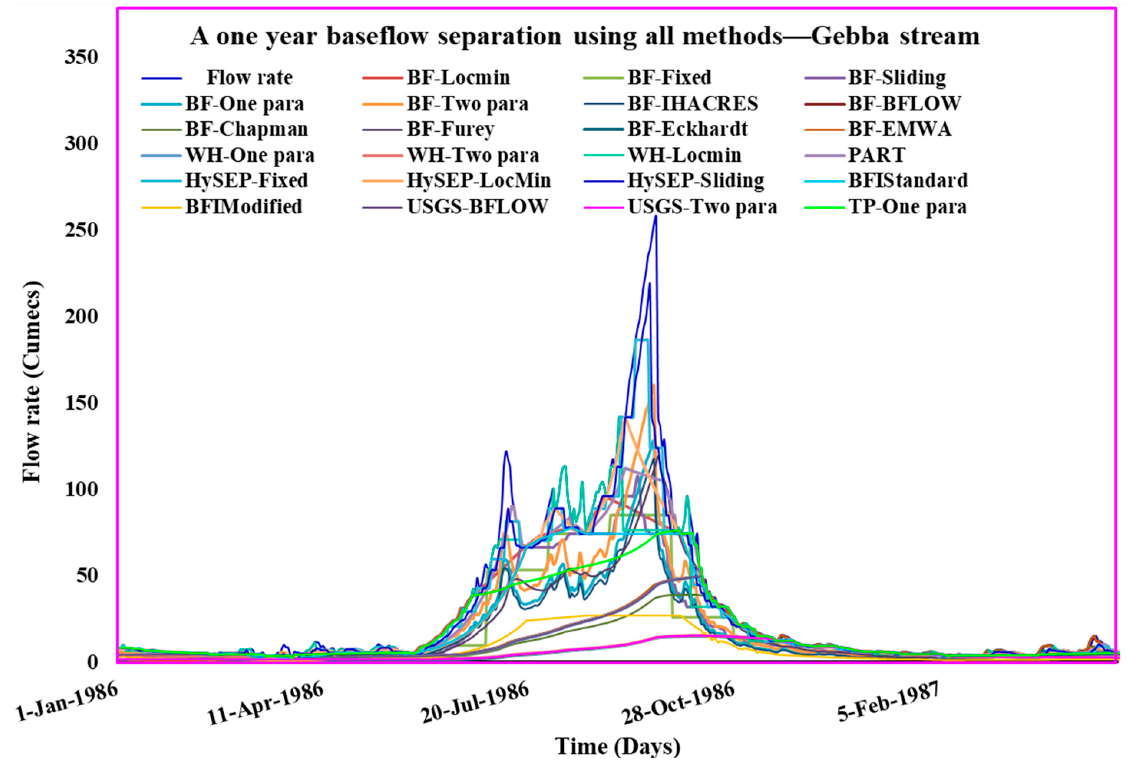
Figure 16. Baseflow separation using all automated methods for the Gebba stream. (Results of all methods are displayed together. This figure shows a one-year baseflow separation).